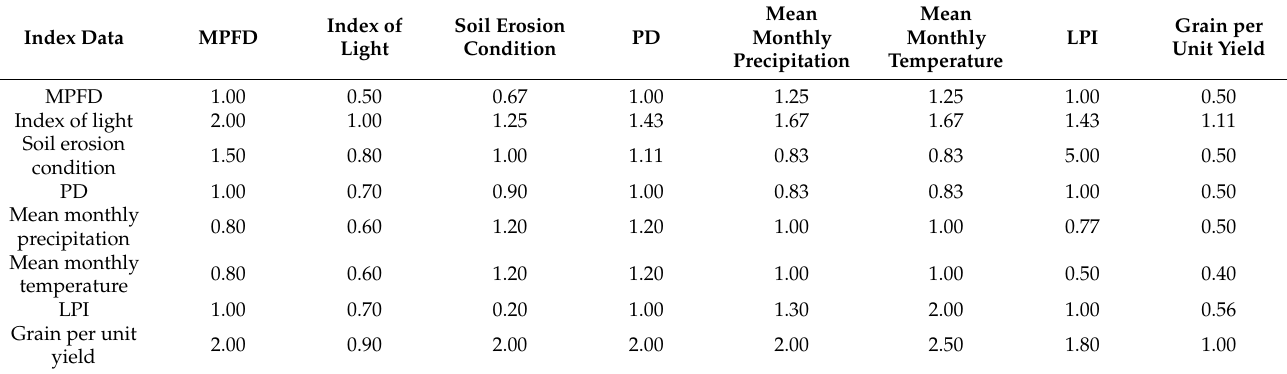
Table 4. Index judgment matrix.